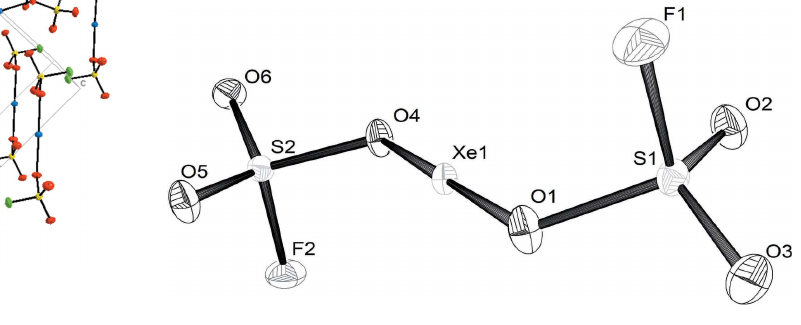
Figure 1 The molecular structure of the title compound, with displacement ellipsoids drawn at the 50% probability